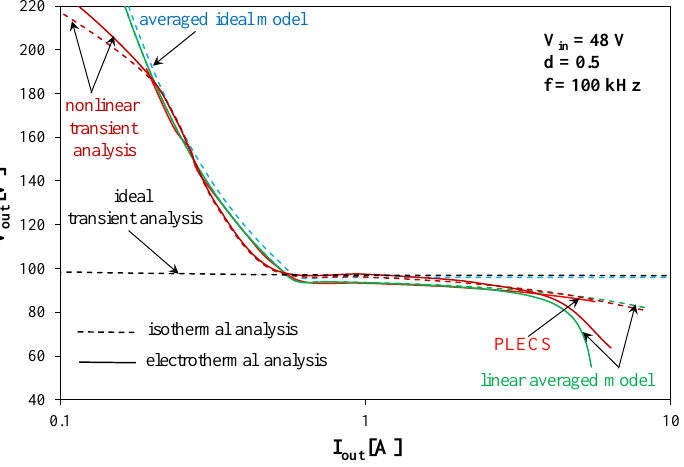
Figure 7. Computed dependences of the converter output voltage on its output current at V in = 48 V.